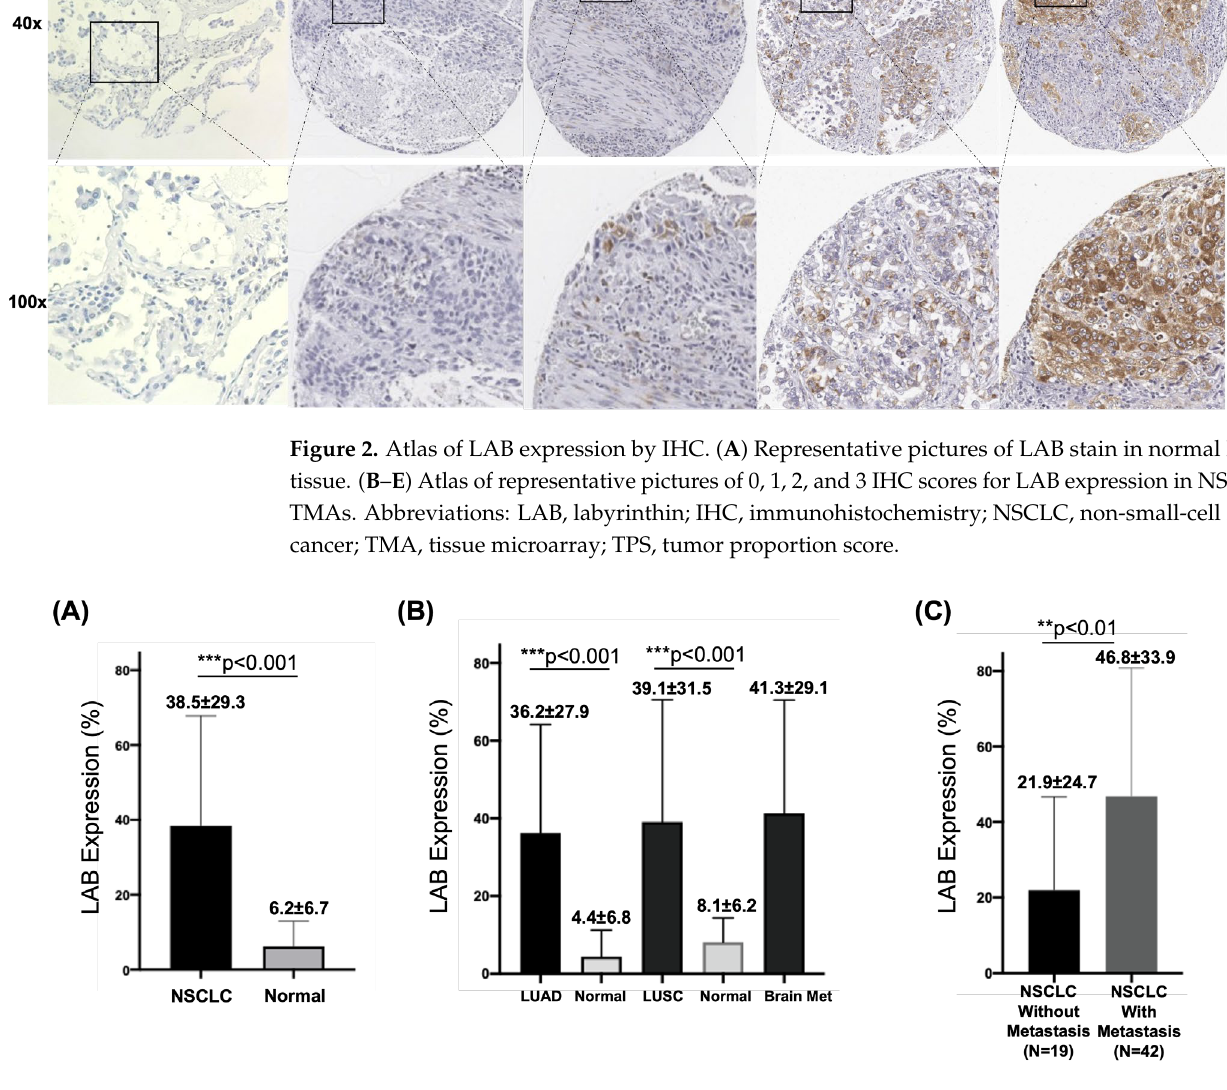
Figure 3. LAB expression and NSCLC metastasis. ( A ) Increased LAB expression was detected in NSCLC compared to matched, non-cancerous tissues. ( B ) Increased LAB expression was detected in LUAD and LUSC compared to matched, non-cancerous tissues, and brain metastasis. ( C ) Higher LAB expression was associated with NSCLC metastasis. ** p < 0.01 and *** p < 0.001 for statistical